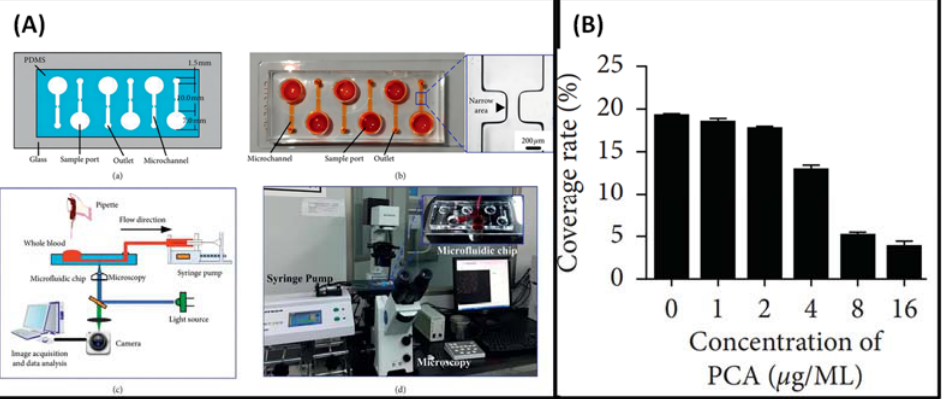
Figure 16. ( Aa ) Schematic diagram of the microfluidic chip. ( Ab ) Physical diagram of the microfluidic chip. ( Ac ) Schematic diagram of the working principle of the analyzed system. ( Ad ) Photograph of the analytical system. ( B ) Histogram of platelet surface coverage for different concentrations of pro-catechin. The image from [22], Copyright 2021, Hindawi.